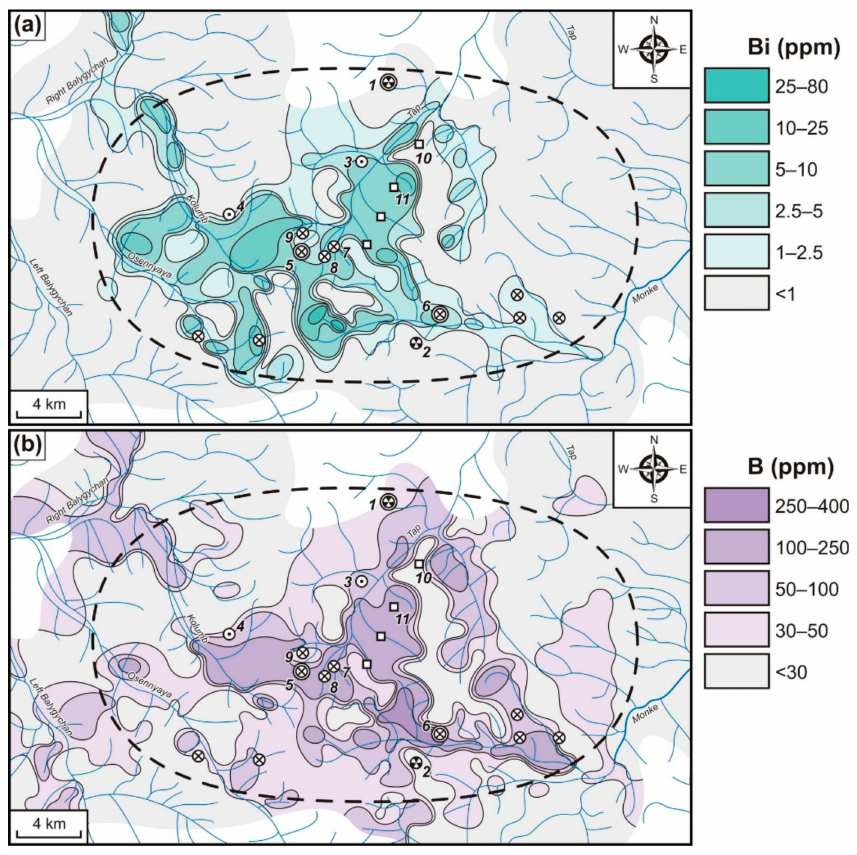
Figure 5. The Pestrinsk SBS. Exogenous Bi ( a ) and B ( b ) AGCFs identified through SSs (survey at 1:200,000 scale).